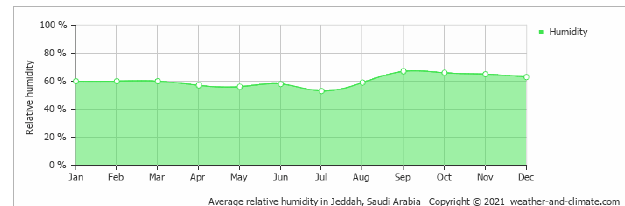
Fig. 8. Jeddah Saudi Arabia average monthly temperature, 1978-2018 (Source: [30])